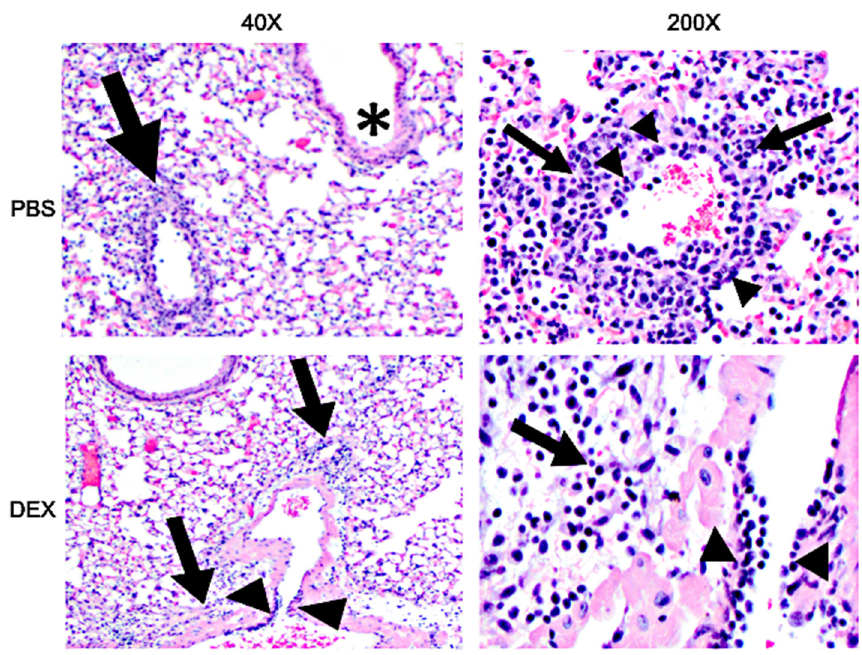
Figure 7. H&E staining of lungs: 40× ( left ) and 200× ( right ) magnification photomicrograph of a lung of a mouse that was treated with PBS (top) or DEX (bottom) and infected with IBV on day 8 pi. Bronchiolitis (asterisks), perivascular inflammation (arrows), vasculitis, (arrowheads).